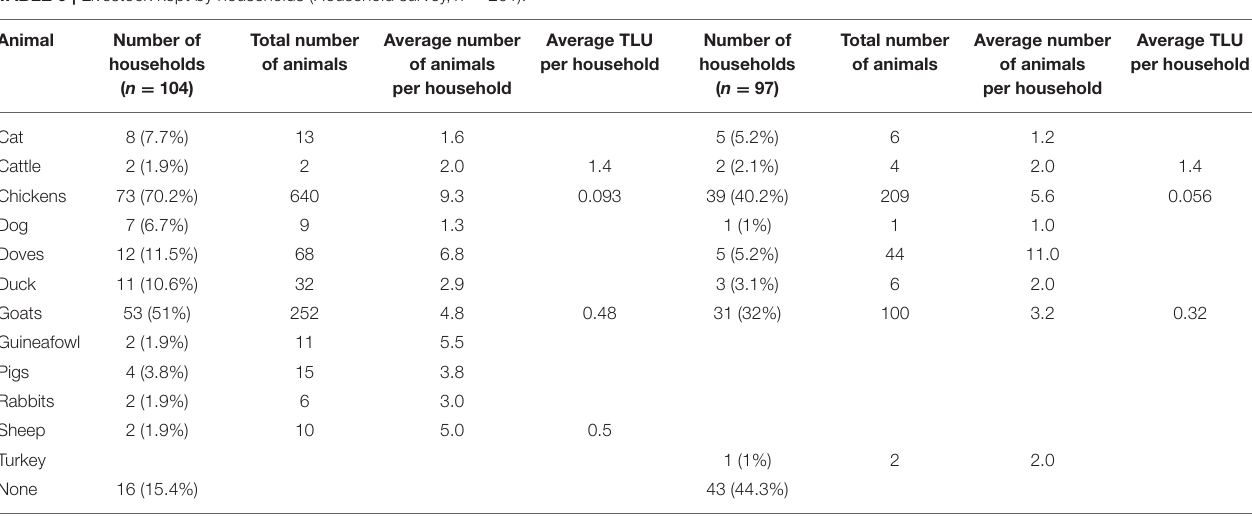
TABLE 6 | Livestock kept by households (Household survey, n = 201).